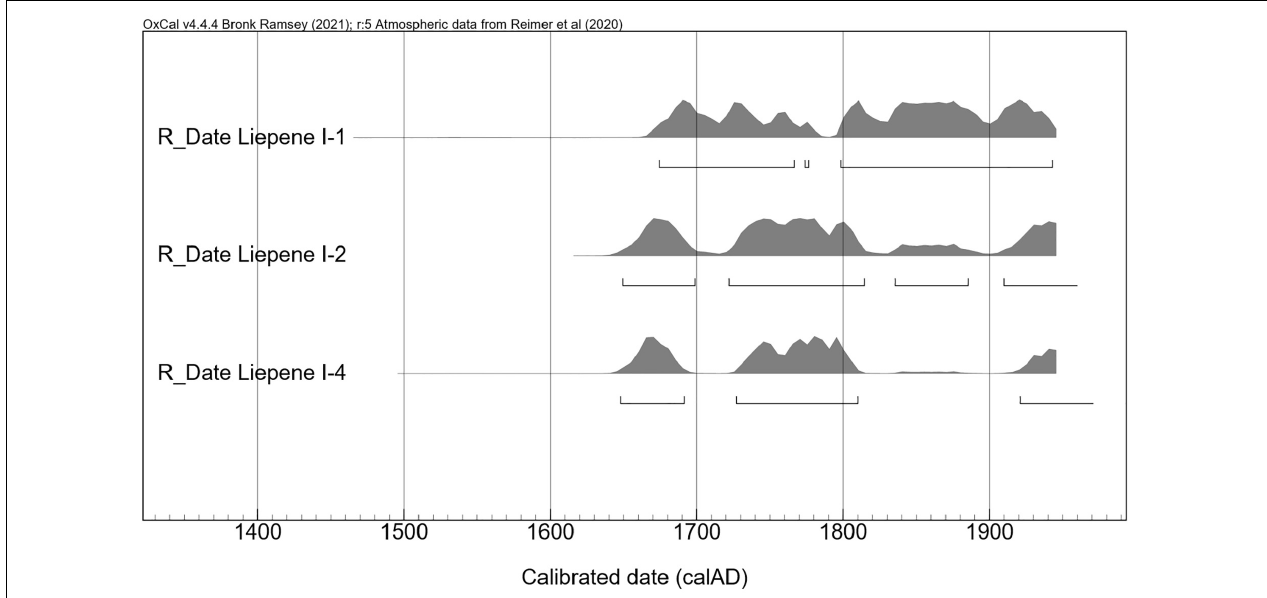
FIGURE 6 | Graph of calibrated dates of three 14 C-dated pine trunk remnants (coastal stretch 5, group